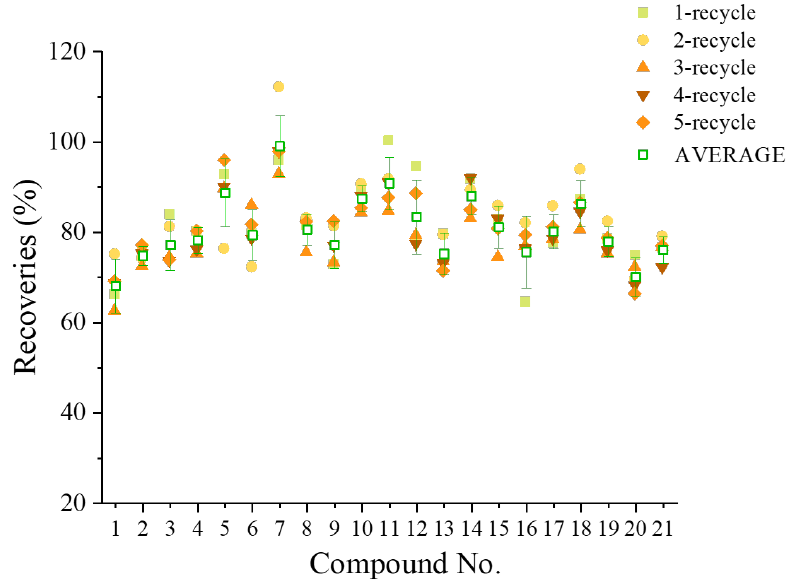
Figure 6. Recovery performance of five regenerations for 21 targets in black tea.